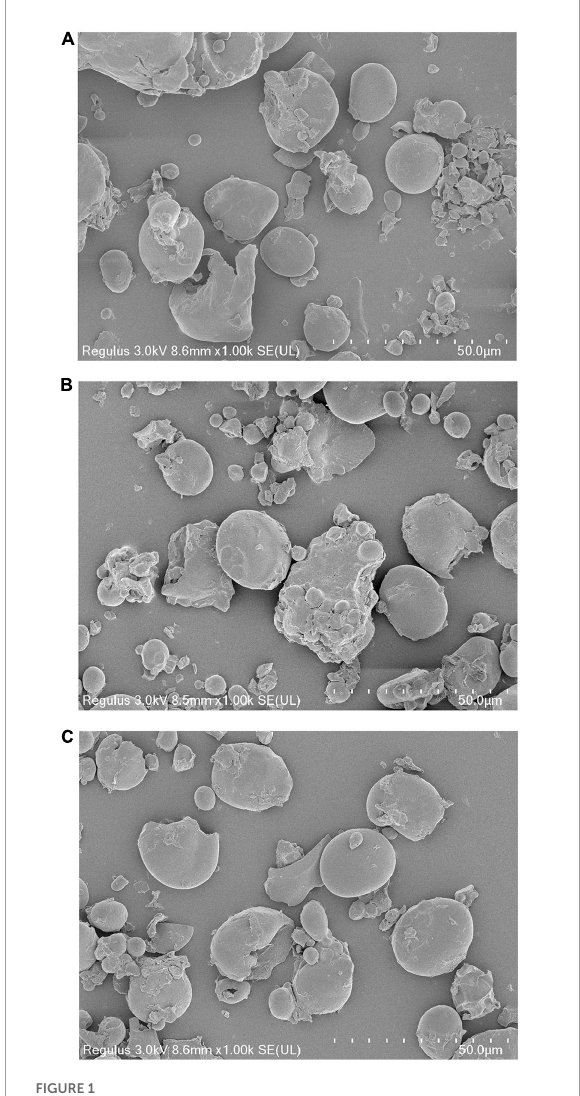
FIGURE1 SEM images of WF and modified WF. (A) WF; (B) DW-WF; and (C)